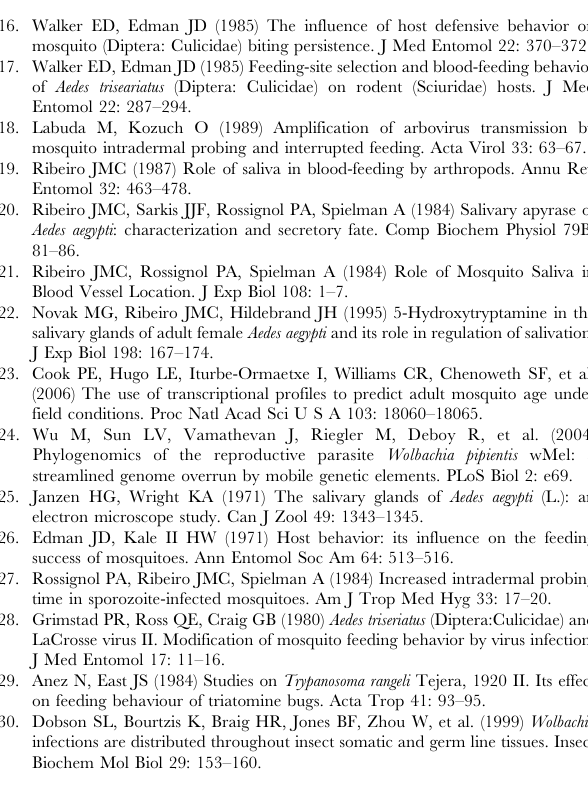
Figure S1 PCR analysis to detect Wolbachia in mosquito saliva. Mosquito (apyrase) or Wolbachia (WSP) specific primers in infected (InfMq) or uninfected mosquitoes (UnMq), saliva (InfSal or UnSal) or salivary glands (InfSG or UnSG). Specific bands were only detected in whole mosquitoes or salivary glands. Neg= negative control; M=100bp NEB DNA ladder. Found at: doi:10.1371/journal.pntd.0000568.s002 (1.56 MB TIF) Video S1 Video of jittering behavior (Shaky) seen in w MelPop infected mosquitoes only, aged 35 days. Found at: doi:10.1371/journal.pntd.0000568.s003 (6.89